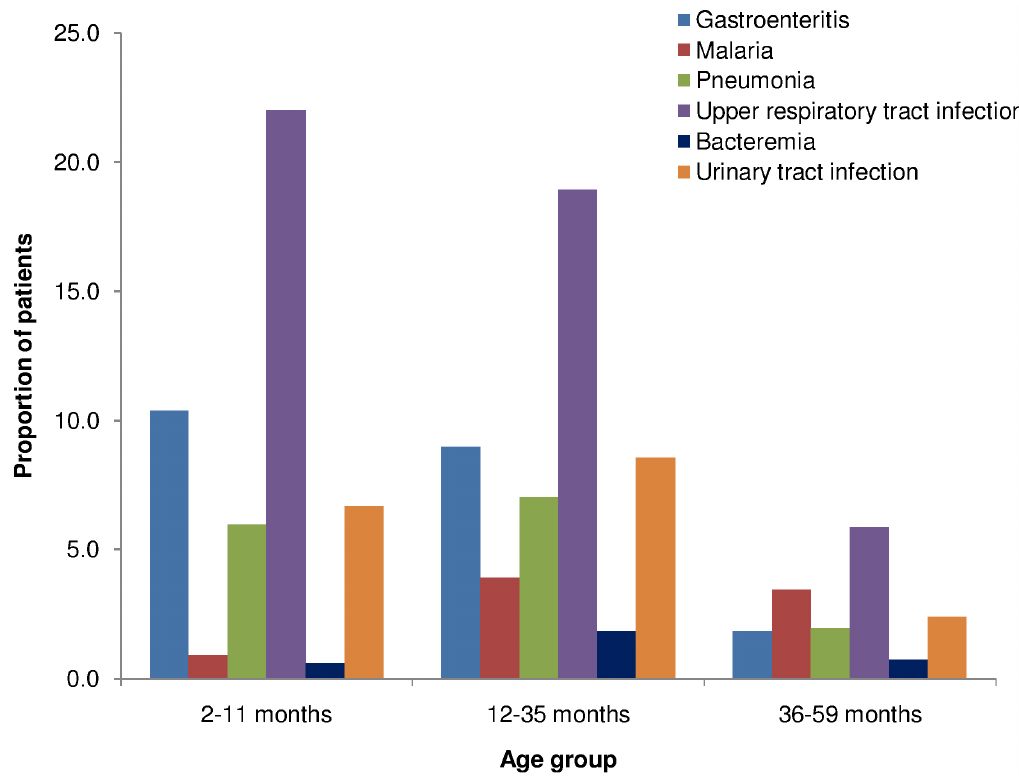
Figure 2. Distribution of common diagnosis according to age group.